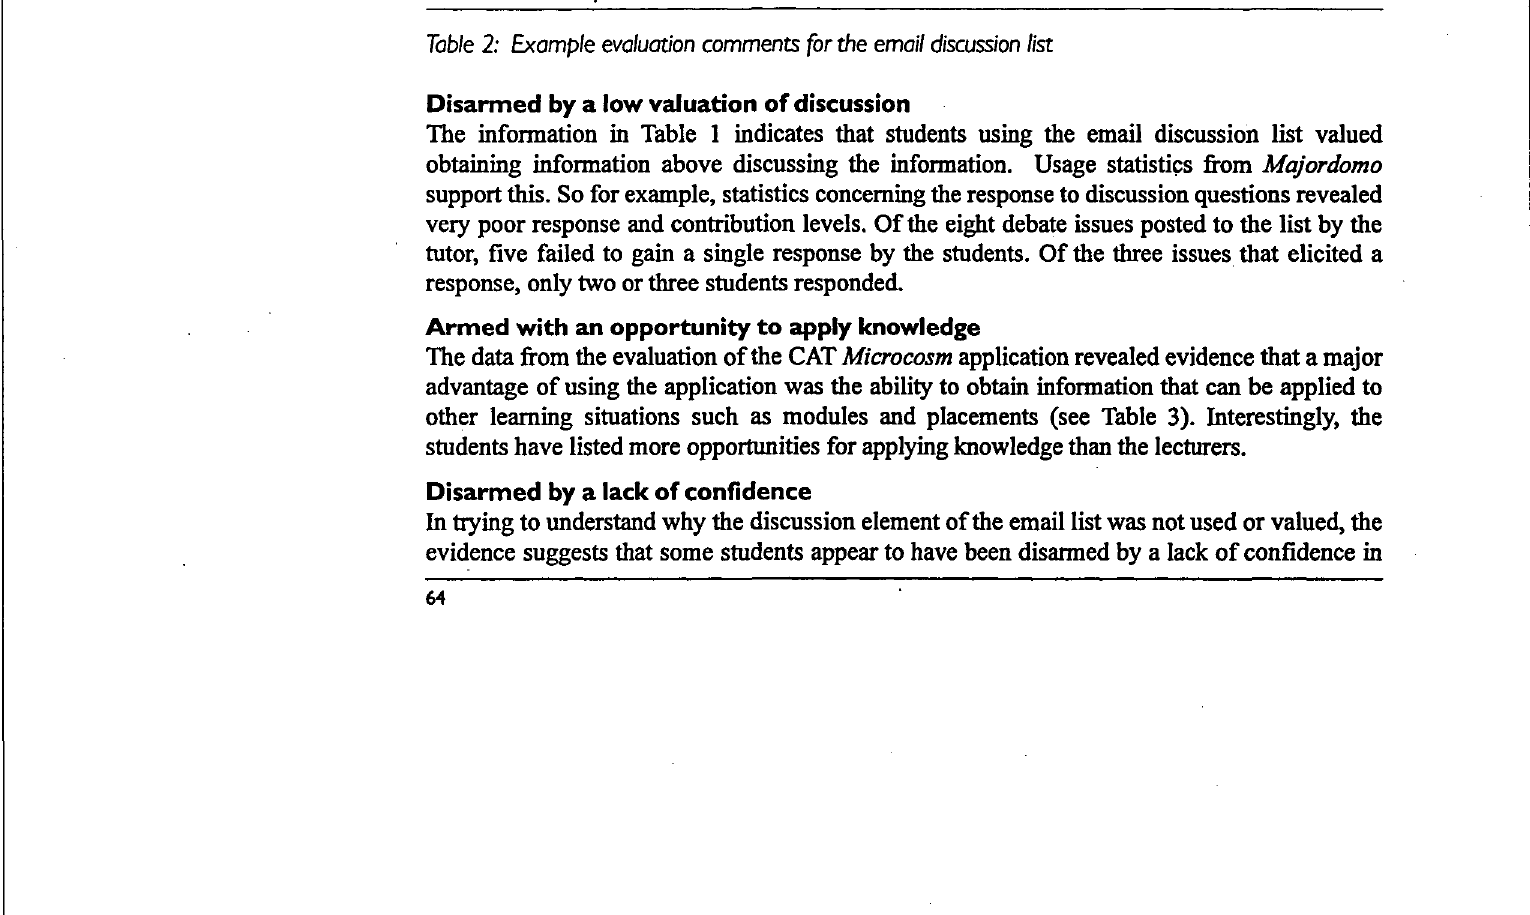
Table 2: Example evaluation comments for the email discussion list Disarmed by a low valuation of